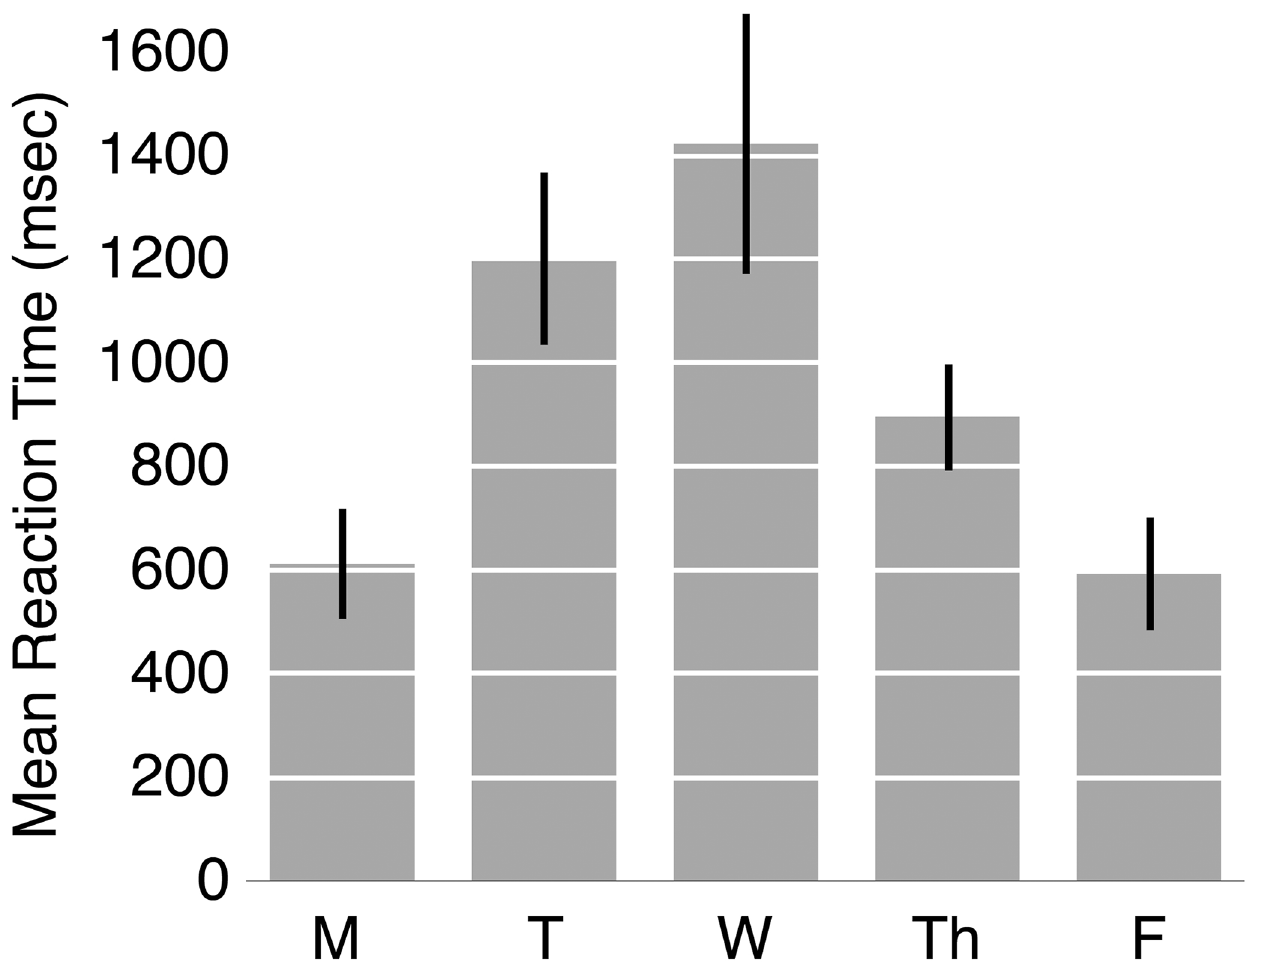
Fig 2. Mean correct reaction times (msec) as a function of weekday for the production task in Study 2. Error bars show SEM.